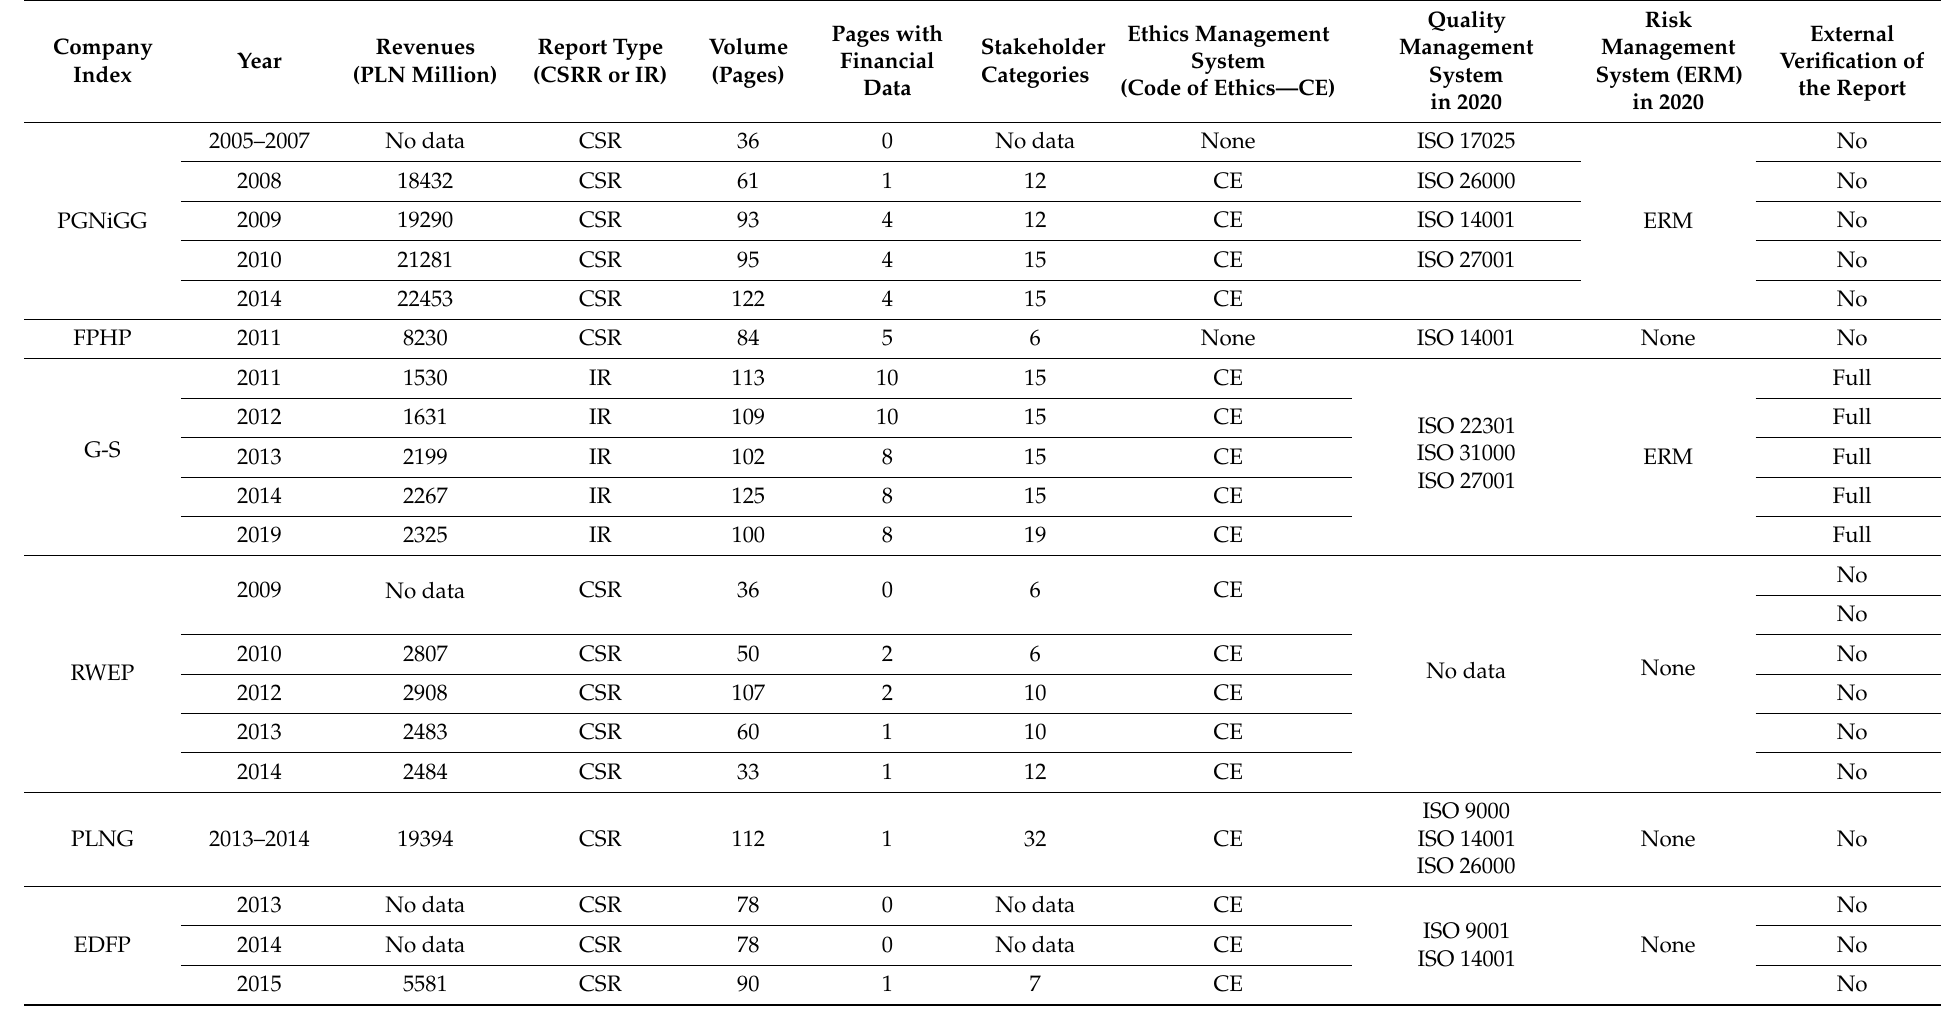
Table 3. Overview of energy company CSRRs and IRs